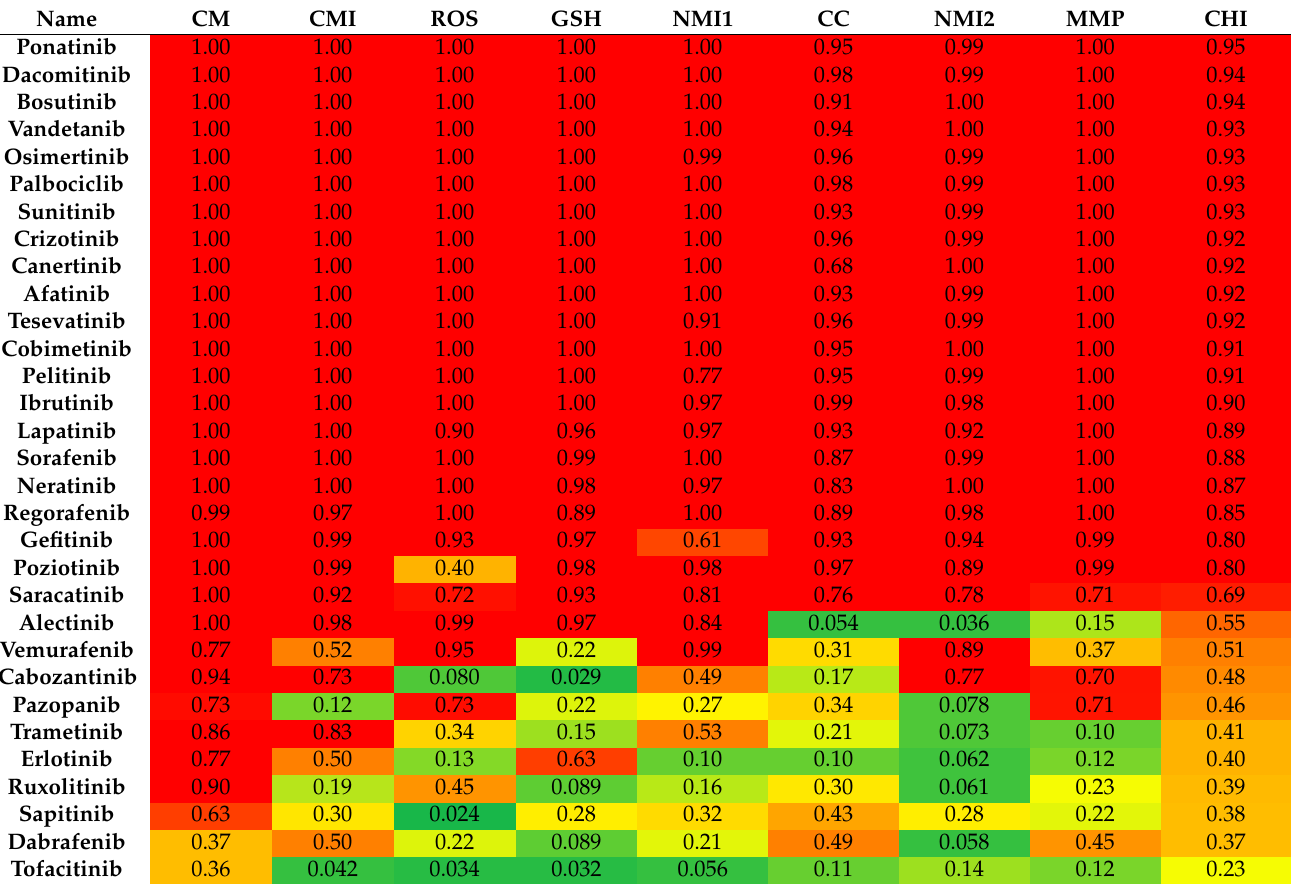
Table 1. Toxicity profiling of a broad range of clinical and literature kinase inhibitors a,b,c